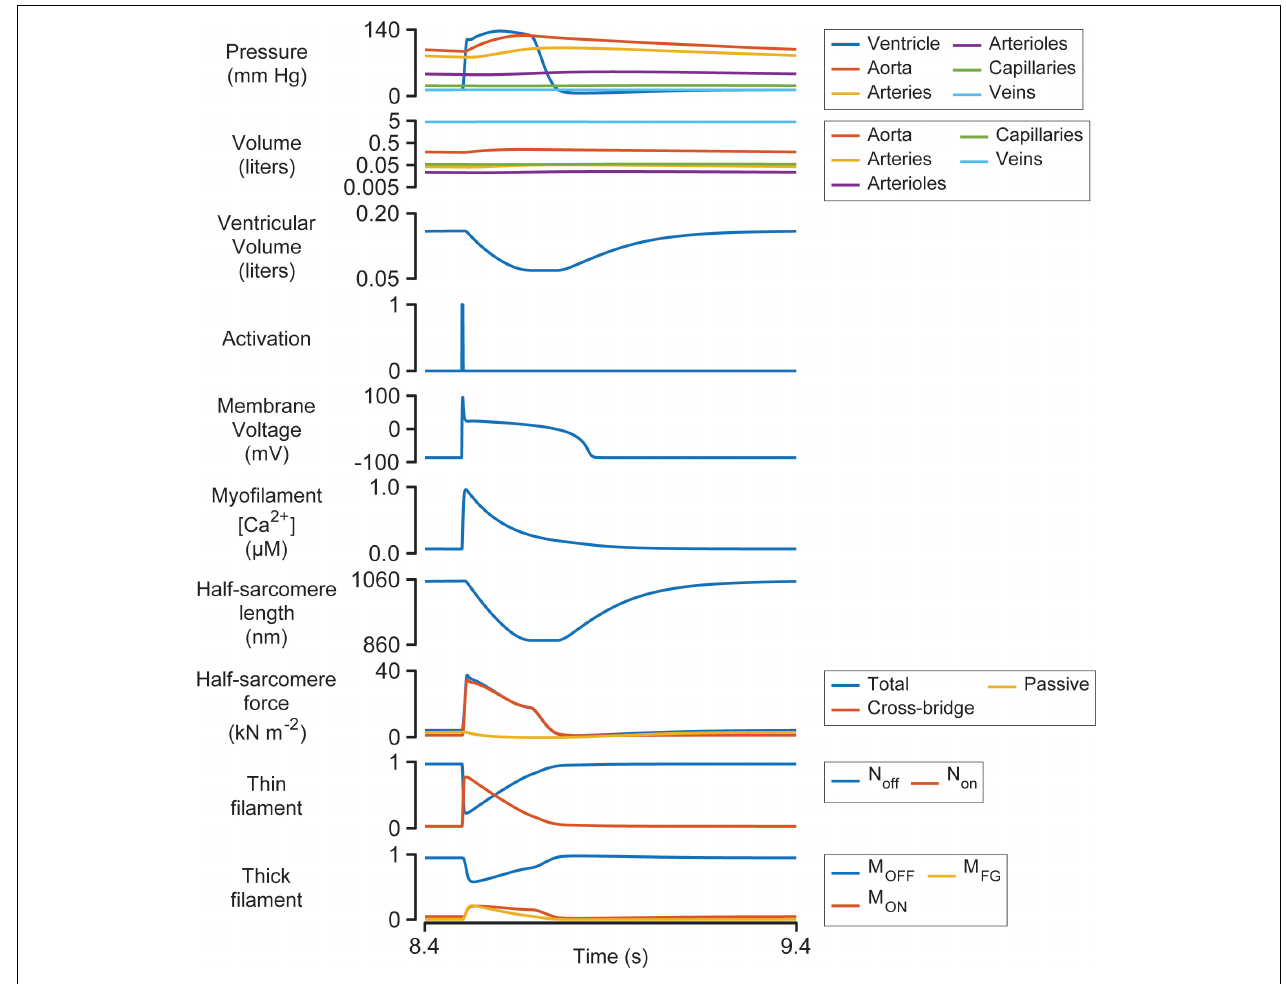
FIGURE 3 | Multiscale simulation of a heart-beat at steady-state. The figure shows the 8th beat from Figure 2 on an expanded